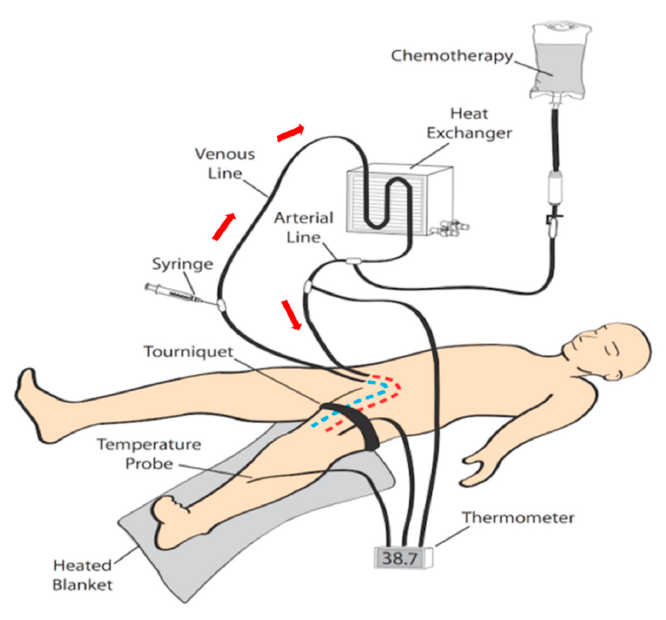
Figure 1. Schematic illustration of the circuit used for isolated infusion of a lower limb (red arrows indicate direction of flow of